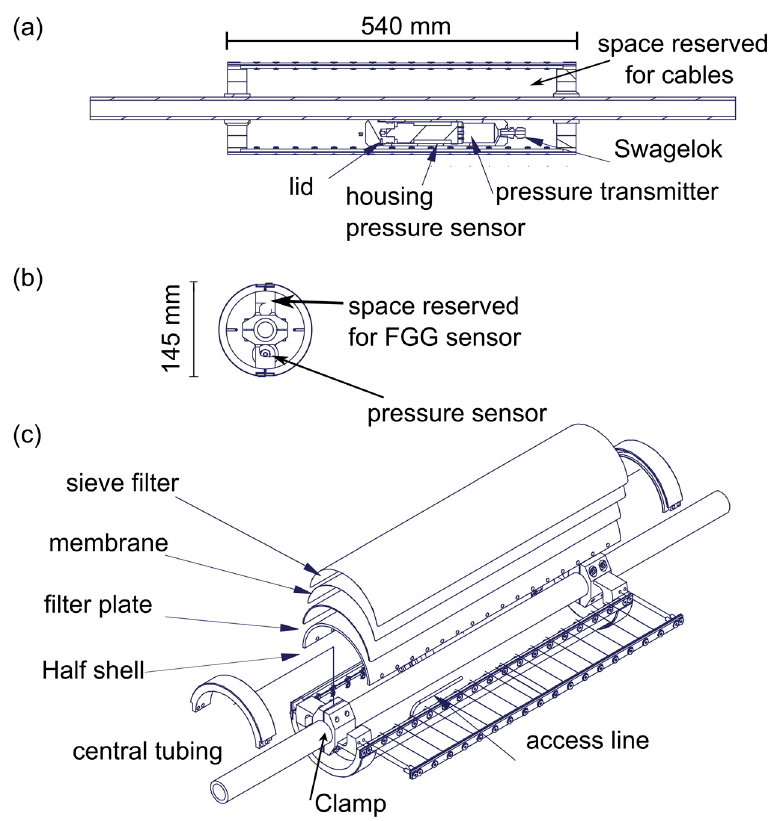
Figure 8. Composition of the cementable tube pore pressure sensor (CTPP). Shown is (a) crosscut along tubing; ( b ) crosscut orthogonal to tubeing, and ( c ) disjointed components. The sensor was along tubing; (b) crosscut orthogonal to tubeing, and (c) disjointed components. The sensor was developed to create an open space within the cemented borehole to allow the measurement of dy- namic pressure signals. The construction ensures that all cables of other devices can pass through the interior while also installing an FBG sensor at the same location. the interior while also installing an FBG sensor at the same